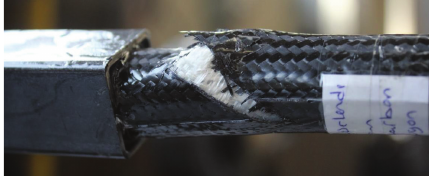
Figure 5: A damaged shaft at the end of torsion test.